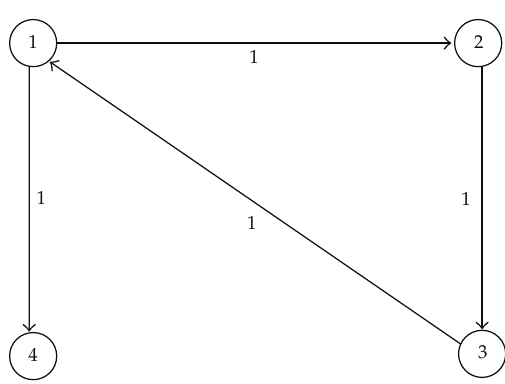
Figure 1: The topology structure of the agents.